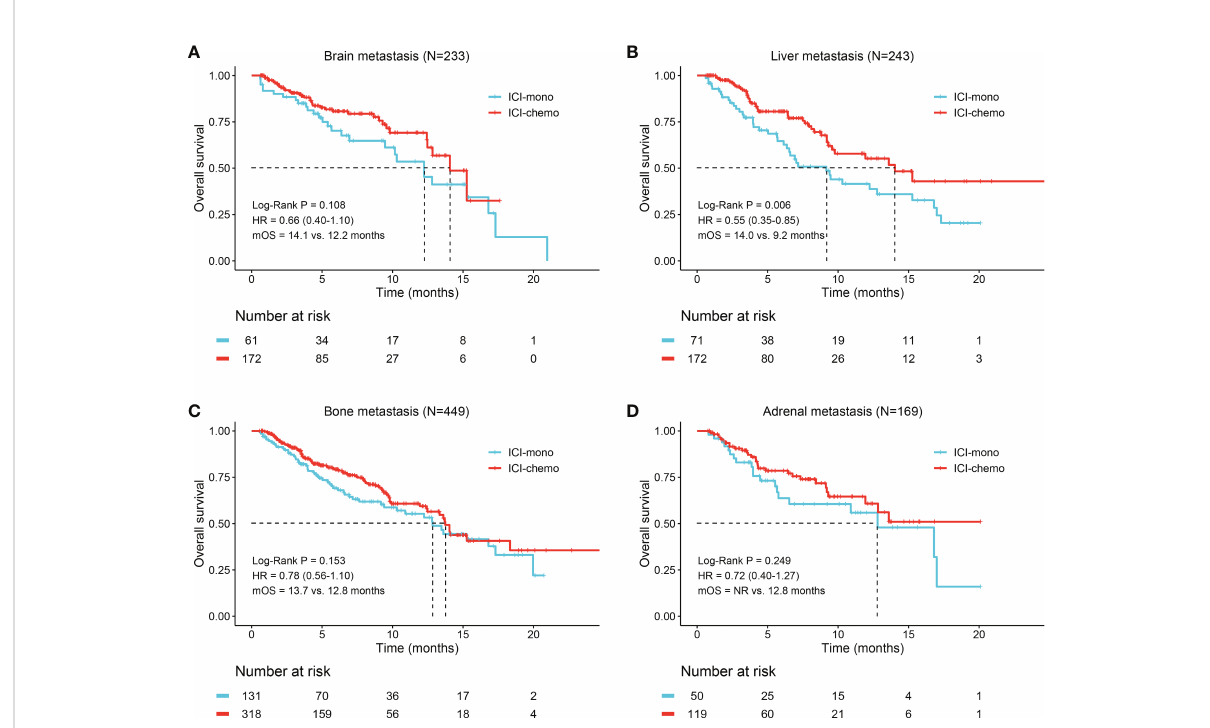
FIGURE 3 Kaplan-Meier curves of overall survival for patients with different metastatic sites. (A) Brain metastasis; (B) Liver metastasis; (C) Bone metastasis; (D) Adrenal metastasis. OS, overall survival; HR, hazard ratio; NR, not